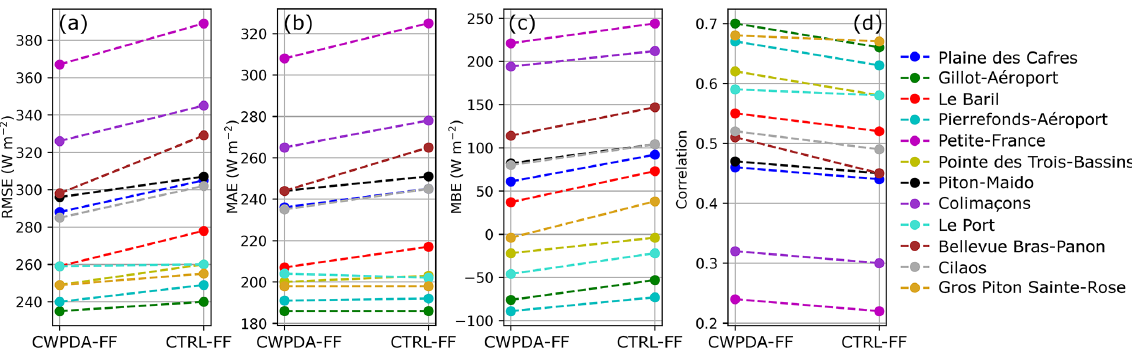
Figure 9. WRF intraday irradiance forecast performance at each site in terms of RMSE (a) , MAE (b) , MBE (c) , and correlation (d) . The difference between the experiments CWPDA-FF and CTRL-FF is shown, and IDW has been applied to the GHI forecasts. The free forecasts cover a total of 44d between 10 December 2017 and 1 March 2018 as listed in Table